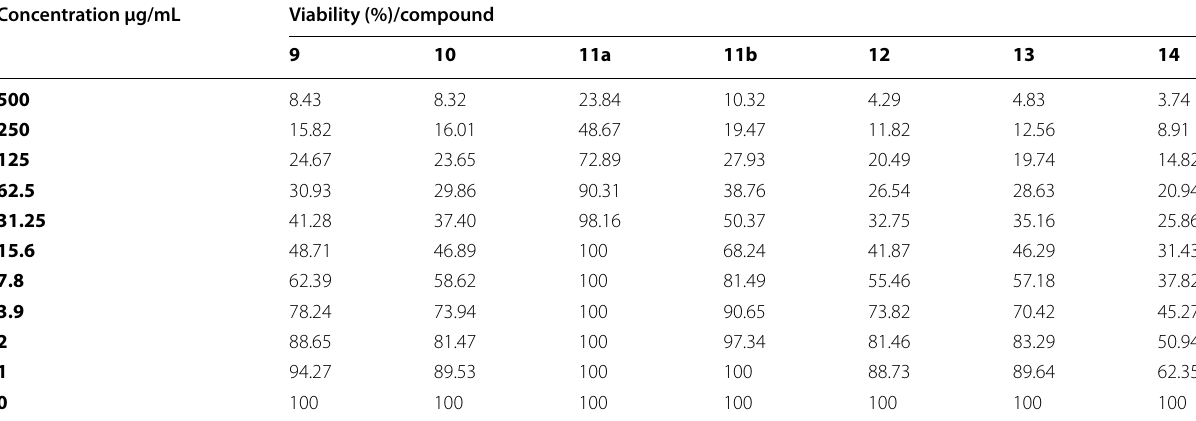
Table 2 Cytotoxicity of compounds 9, 10, 11a, 11b, 12, 13, and 14 against hepatocellular carcinoma cell line HePG2 Concentration µg/mL